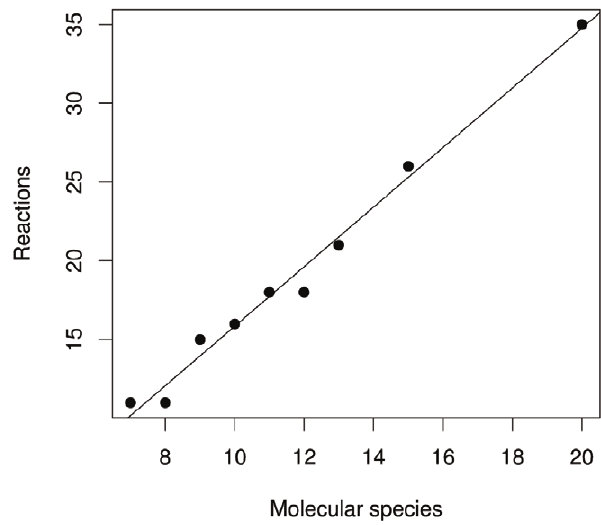
Figure 6. Maximal semantic capacity in random networks. Scatter plot showing the position of the maximal semantic capacity of the random reaction network data (cf. Fig. 5) in a ( D M D | D R D ) -plot. The linear regression of the data shows that the maximal semantic capacity is reached if there are approximately two times more reactions in the system than molecular species: reactions ~{ 3 : 06 z 1 : 89 species .